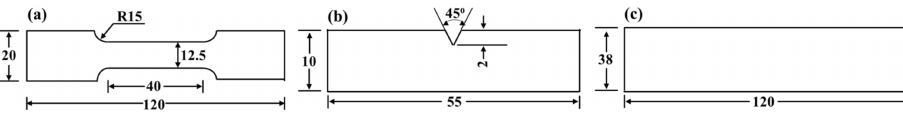
Figure 3. Dimensions of test specimens (unit: mm): ( a ) Tensile test specimen; ( b ) Charpy impact test specimen; and, ( c ) Bend test